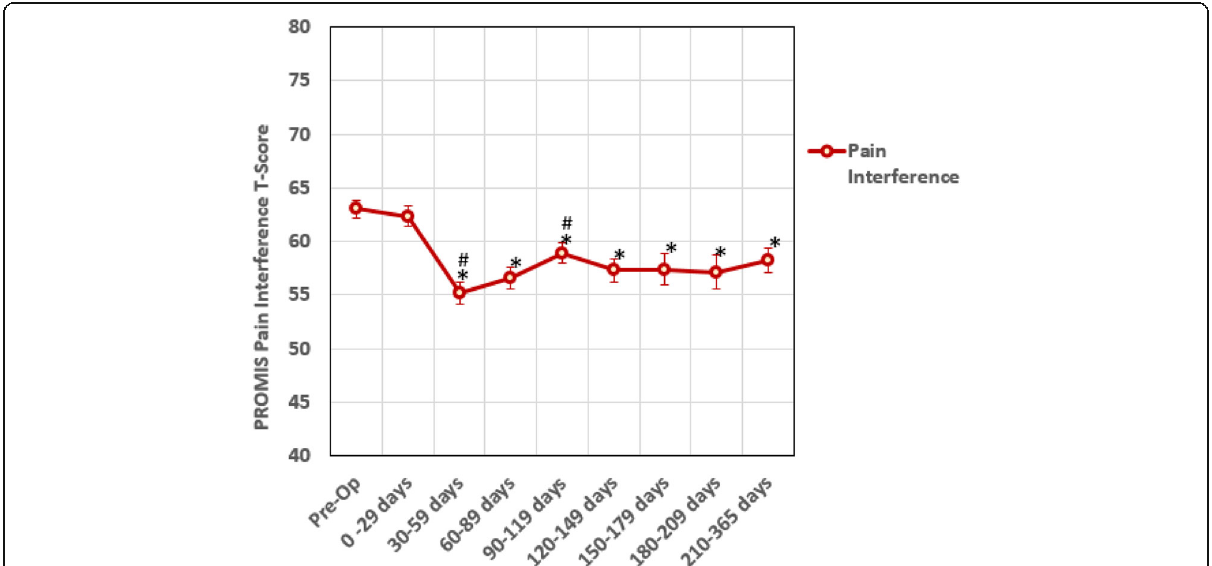
Fig. 2 Recovery roadmap for PROMIS pain interference T-scores for ankle arthrodesis patients. A higher T-score indicates improvement in